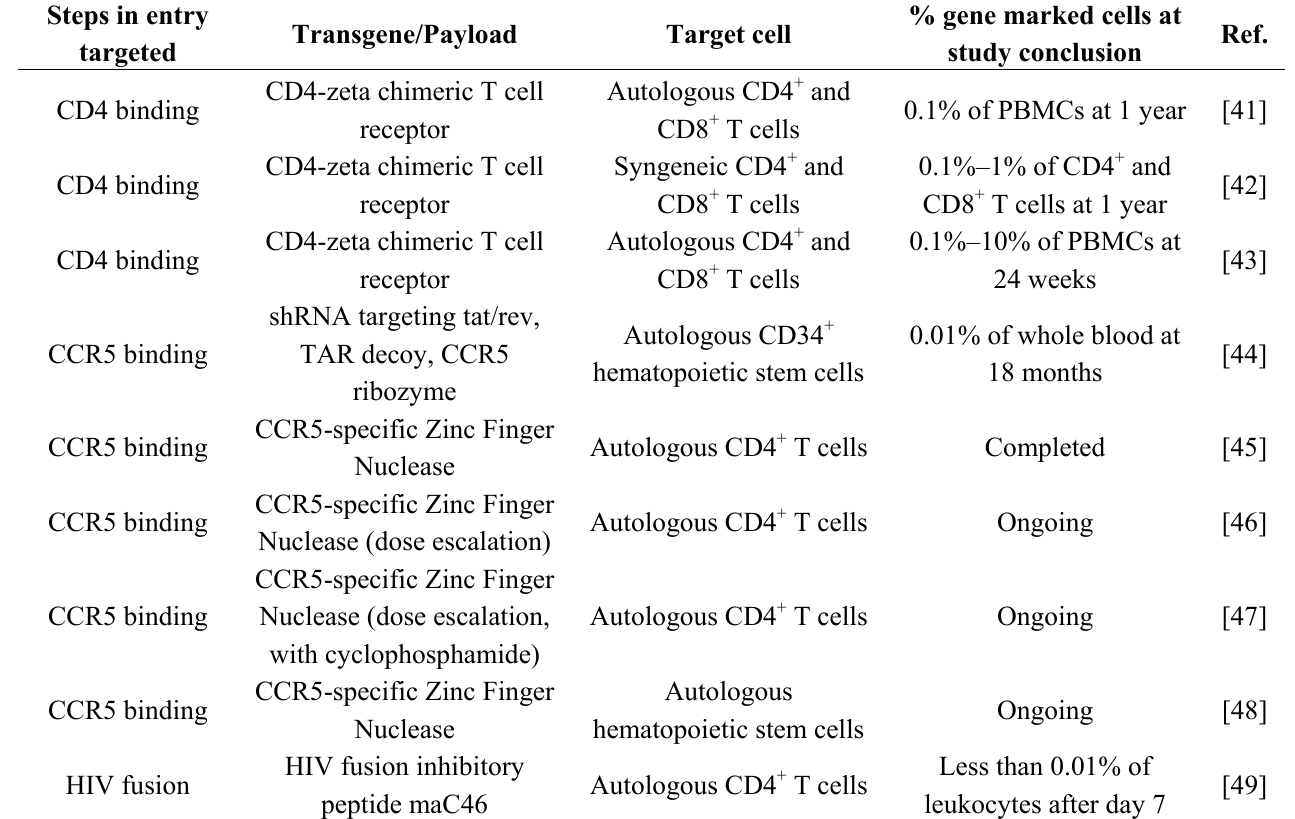
Table 1. Gene therapy clinical trials targeting the major steps in HIV entry. Steps in